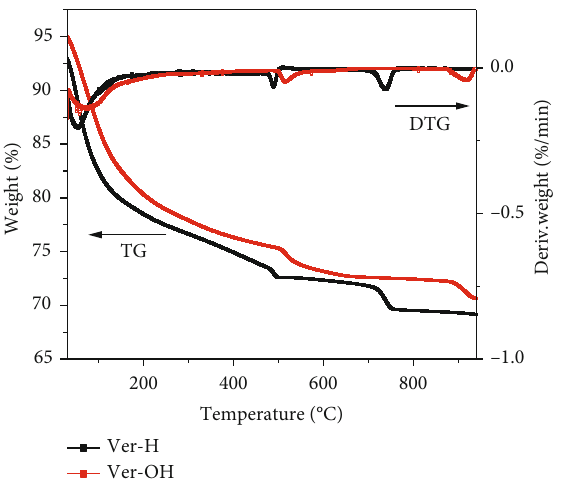
Figure 3: TG and di ff erential TG spectra of vernadite samples.